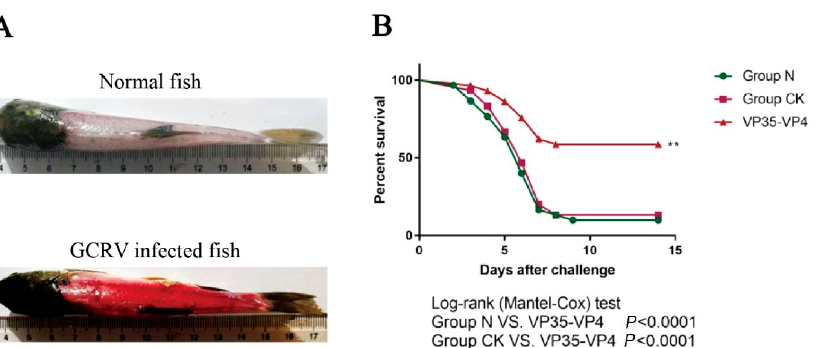
Figure 8. Results of GCRV challenge test. ( A ) Hemorrhagic symptoms induced by GCRV-106. Images show representative fish specimens in the GCRV-106 and control groups, with the latter exhibiting typical muscular hemorrhagic symptoms. ( B ) Cumulative survival percentage of the experimental fish challenged with the virus. ** p < 0.01.